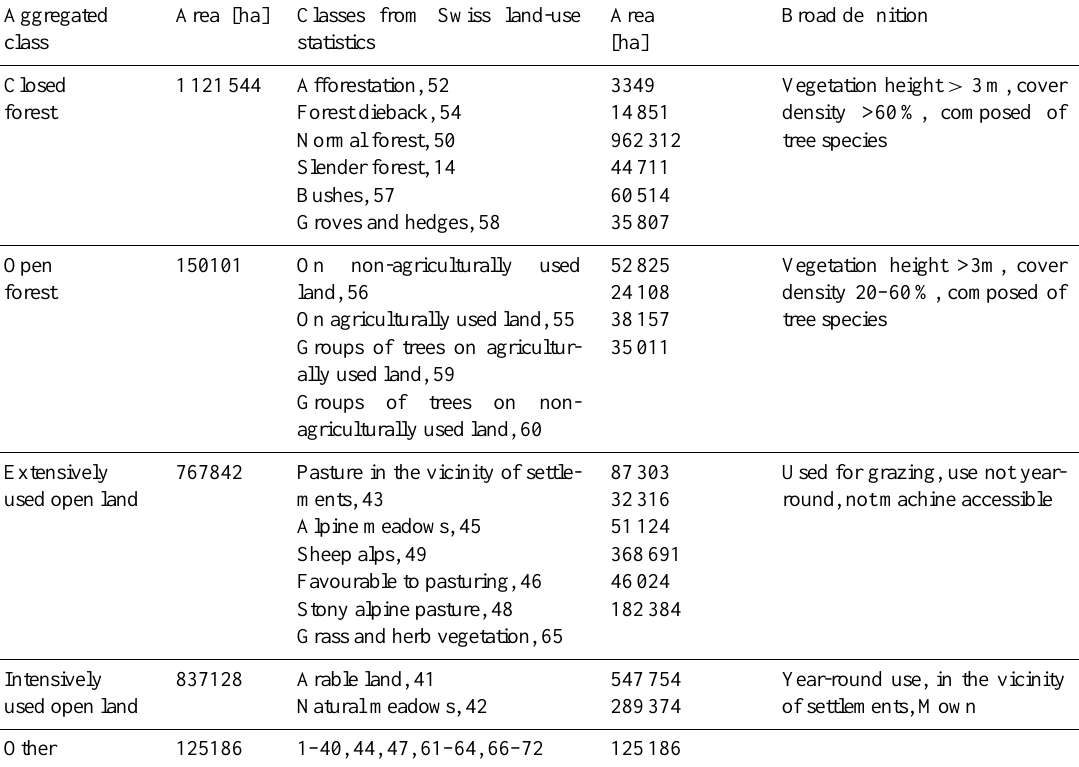
Table A5. Aggregation of land-use classes from Swiss Arealstatistik (ASCH85, ASCH97 and ASCH04) adapted from Rutherford et al.